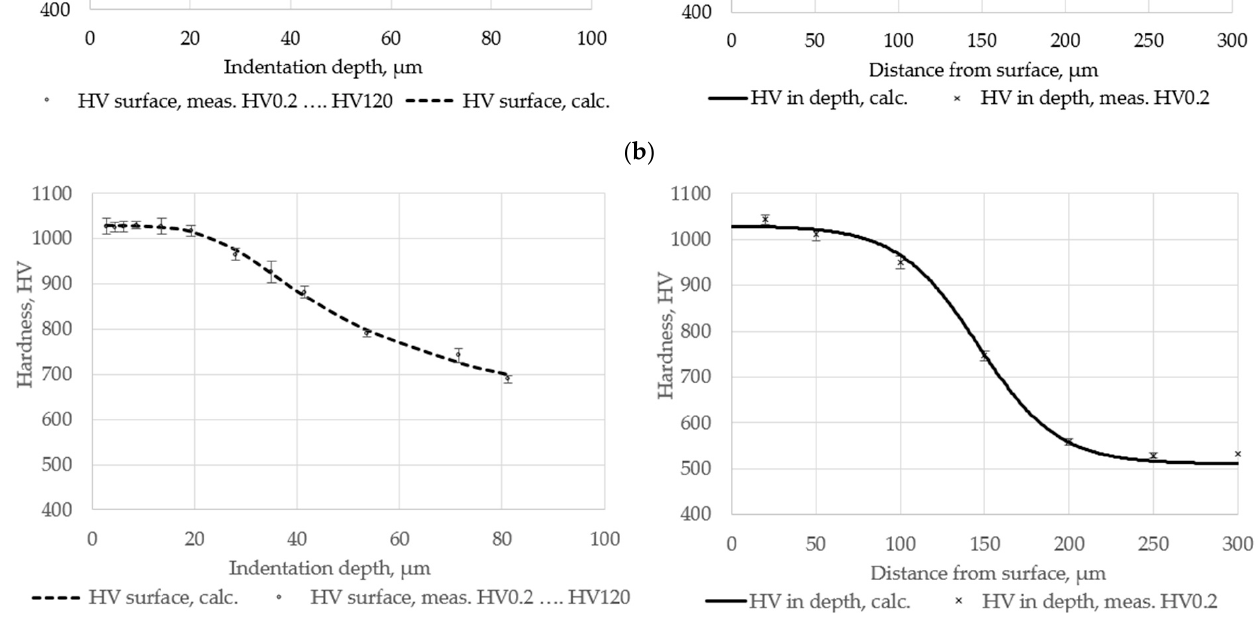
Figure 8. Surface hardness ( left ) and the in-depth hardness distribution calculated from this ( right ): ( a ) 60 min nitrocarburizing; ( b ) 120 min nitrocarburizing; ( c ) 480 min nitrocarburizing.